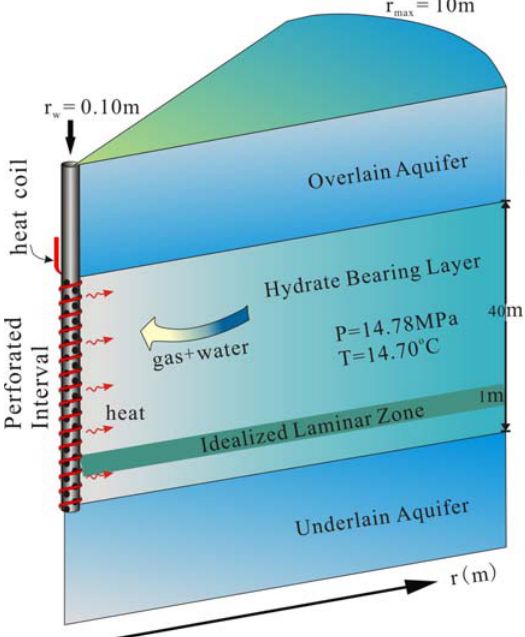
Figure 2. Schematic illustration of gas production from hydrate deposit by thermal stimulation (modified from [3]). Formation temperature is increased by heat coil at the perorated interval of the vertical well, which makes the hydrate dissociated and gets gas